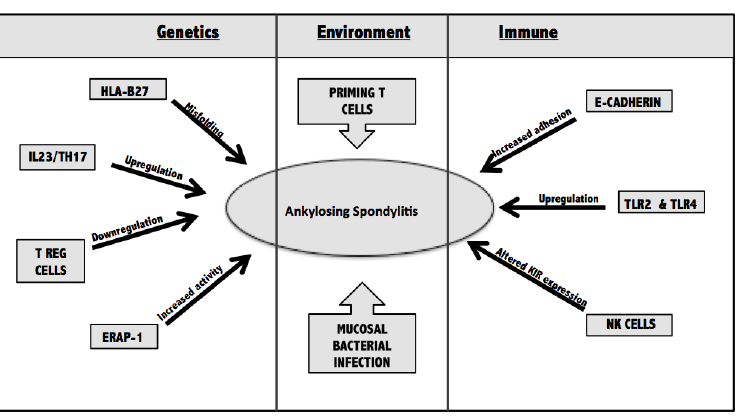
Figure 1. Major Contributors to the Development of Ankylosing